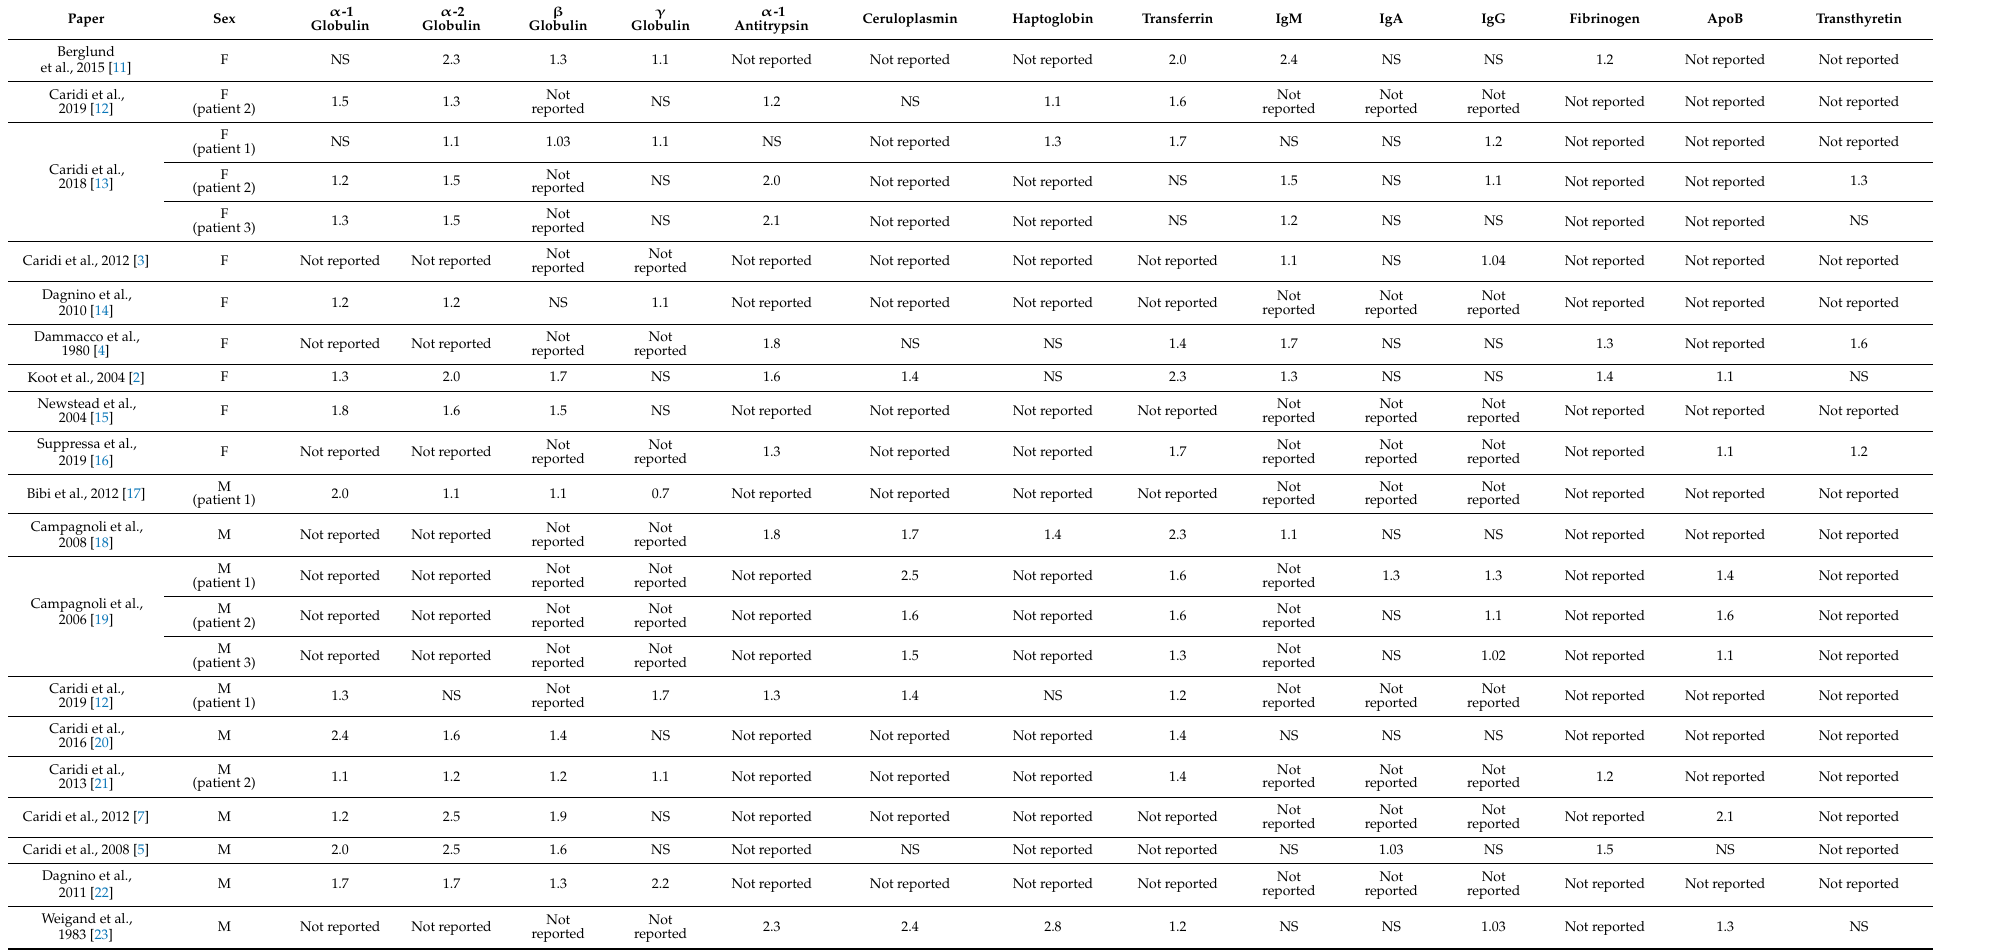
Table 2. Fold change of proteins analyzed. If a protein concentration was above the reference range reported by the authors, fold change was calculated by dividing the value by the upper level of the reference range. If a protein concentration was below the reference range reported by the authors, fold change was calculated by dividing the value by the lower level of the reference range. Fold change above 1 indicates expression above the reference range, and below 1 indicates expression level below the reference range. NS, not significant (expression level was reported but was within the stated reference